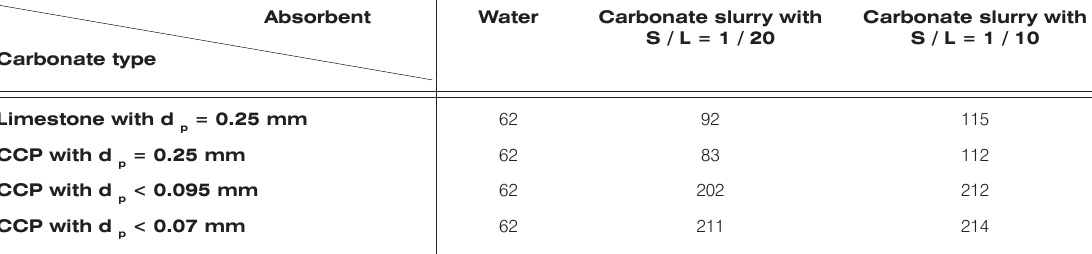
Table 5. Influence of temperature on the final absorption capacity of SO2 in [g SO